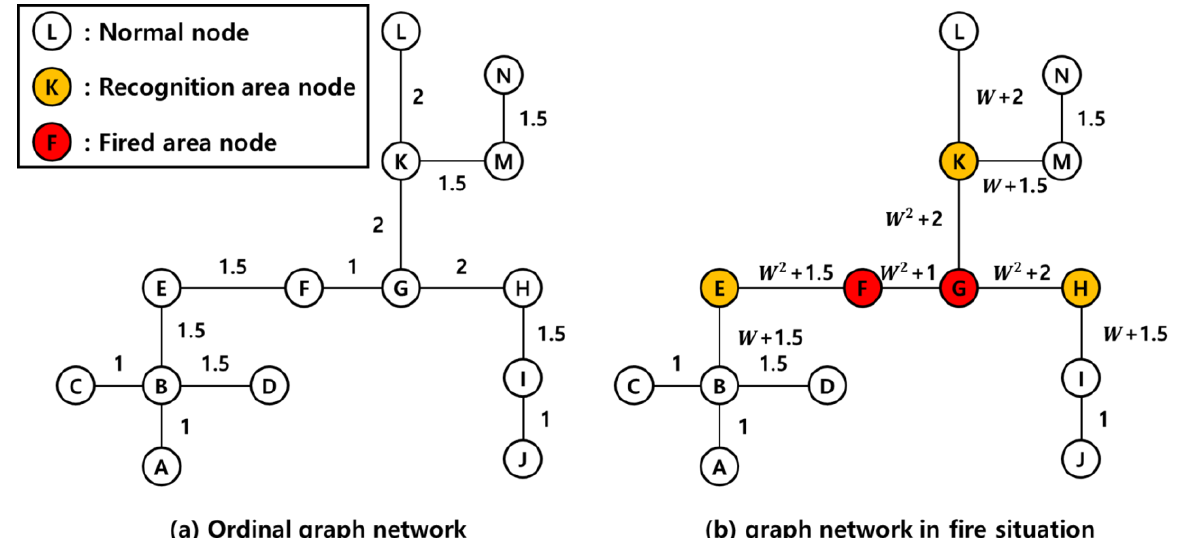
Figure 9. Graph network without and with